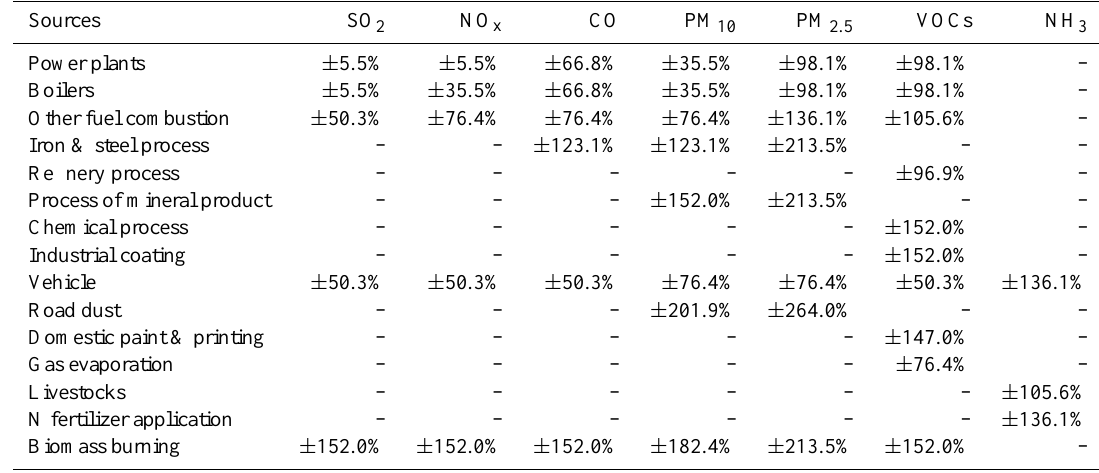
Table 8. Uncertainty assessment of major emission sources in the YRD